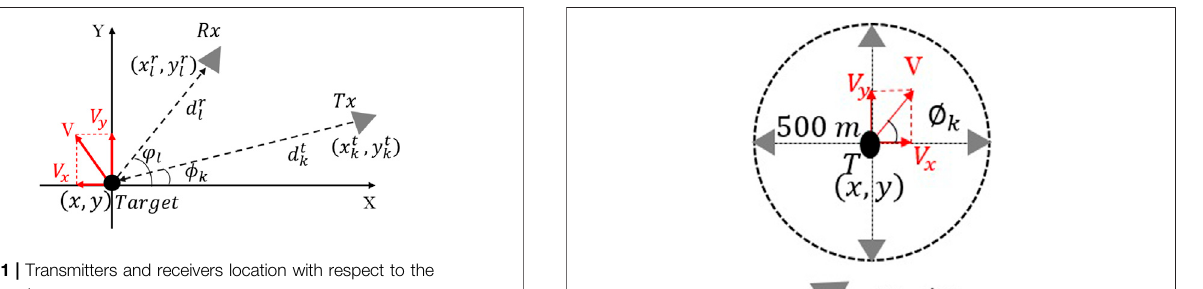
FIGURE 1 | Transmitters and receivers location with respect to the moving target.